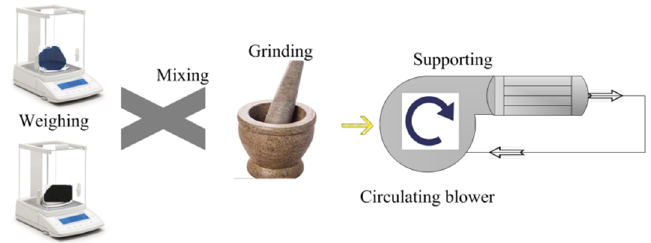
Figure 2. The overall structure of the simulation test bench. 1. Pressure-reducing valve. 2. Gas cyl- inder group. 3,12. Flowmeter. 4. Computer. 5. Gas analyzer. 6. Water bath pot. 7. Quartz tube. 8. Cordierite loaded with PM and catalytic agent. 9. Ball valve. 10. Tube furnace. 11. Pressure gauge. 13. Electronic balance. 14. Gas mixing chamber.